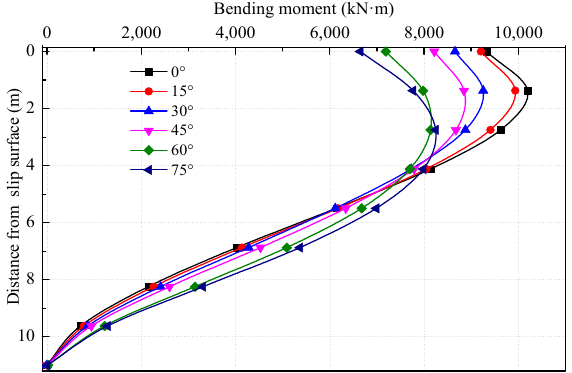
Figure 19. Shear force distributions along the embedded section of the stabilizing pile. Figure 20. Displacement distribution of the embedded section of the stabilizing pile.